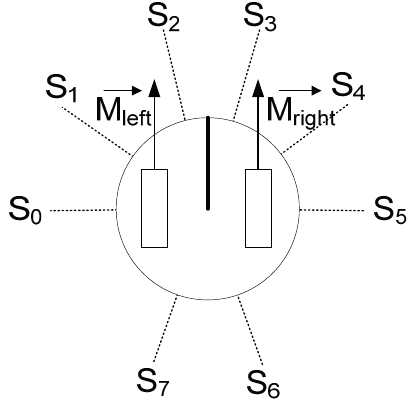
Figure 23. The sensor distribution model